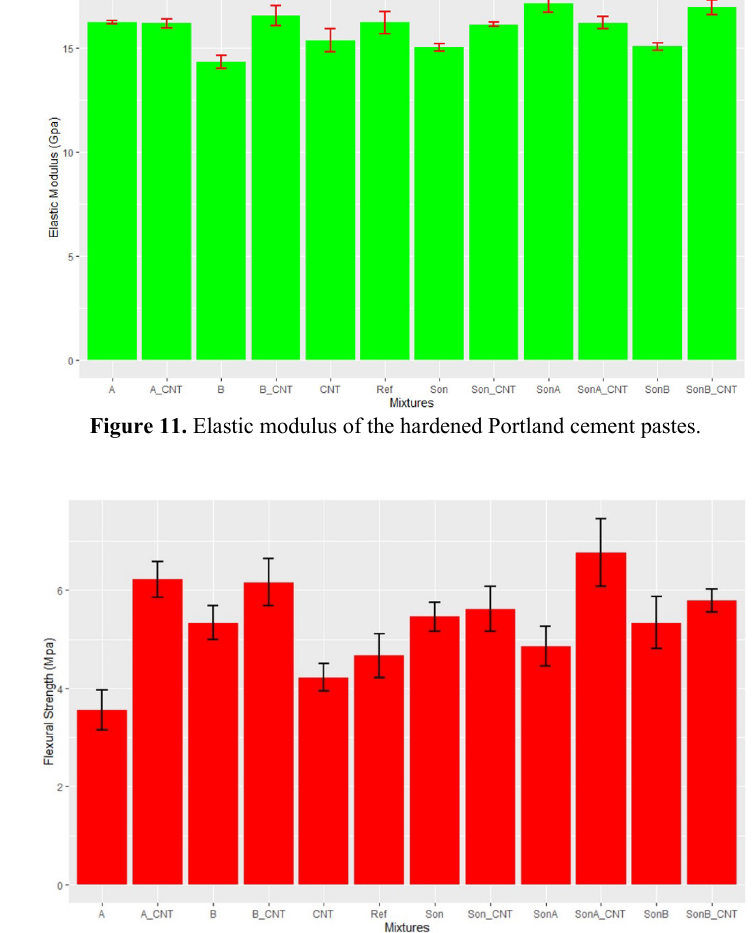
Figure 12. Flexural strength of the hardened Portland cement pastes.